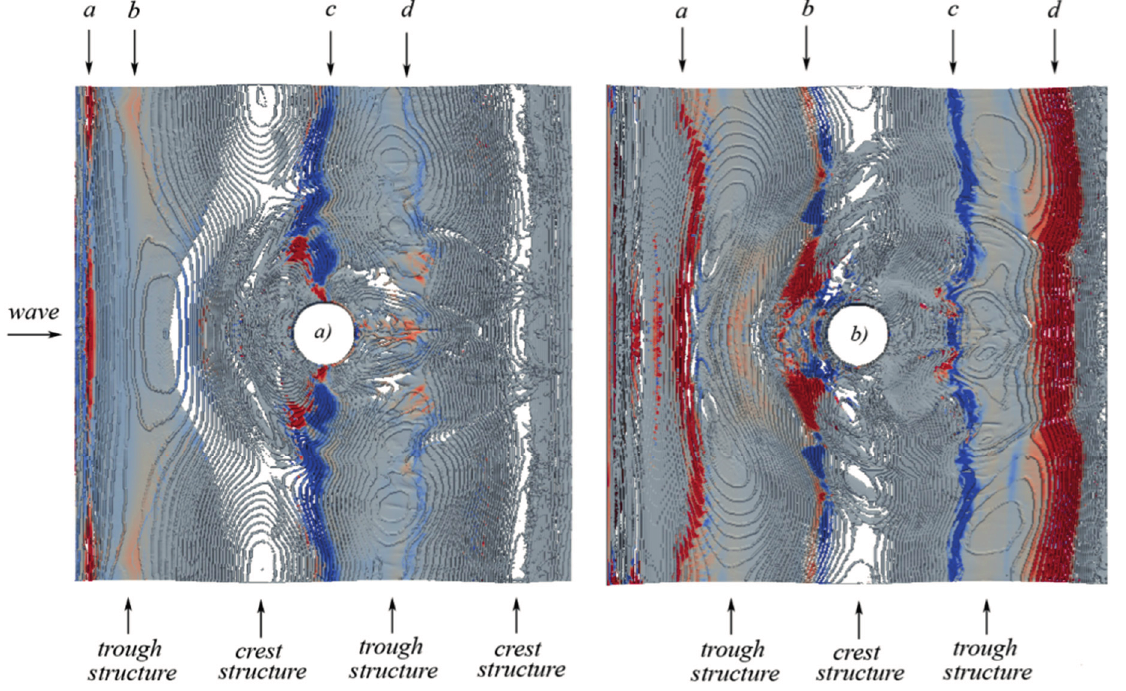
Figure 14. Flow structures as obtained from the solution of the primitive-variable Euler equations. Top view of free-surface profile: ( a